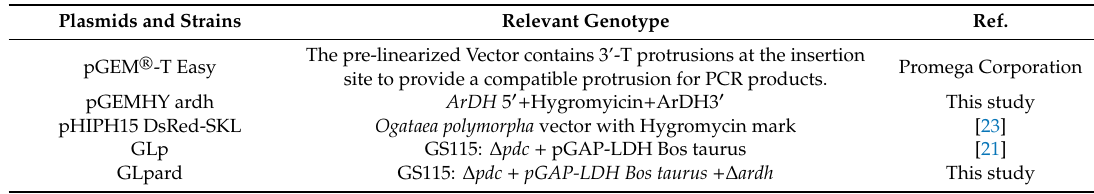
Table 1. Plasmids and strains used in this study.